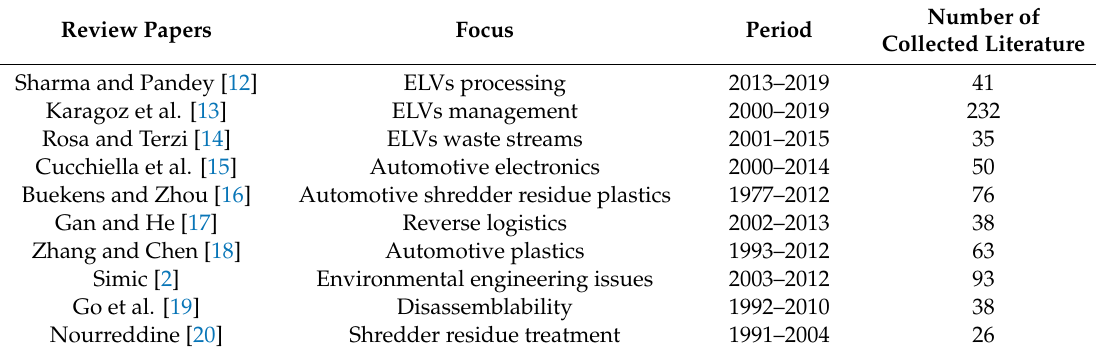
Table 1. The performance of review papers related to reverse logistics of